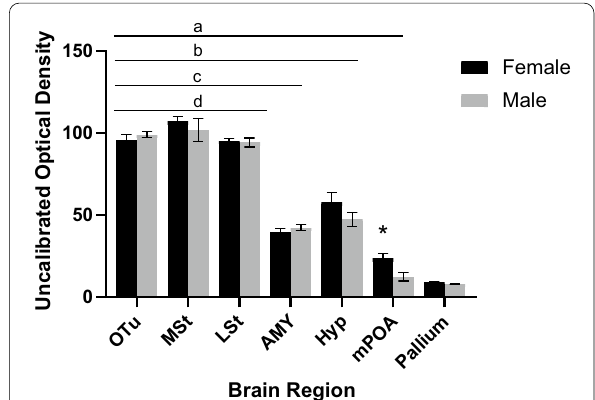
Fig. 2 [3H]Nisoxetine binding in various brain regions of male and female Japanese quail. Each bar and brackets represent the mean of the region SEM. a indicates a significant difference from the ± Pallium, p < .05. b indicates a significant difference from mPOA, p < .05. c indicates a significant difference from Hyp, p < .05. d indicates a significant difference from AMY, p < .05. * indicates a significant sex difference in the mPOA as indicated by *, p < .05. OTu, olfactory tubercle; MSt, medial striatum; LSt, lateral striatum; mPOA, medial preoptic area; AMY amygdala; and Hyp,